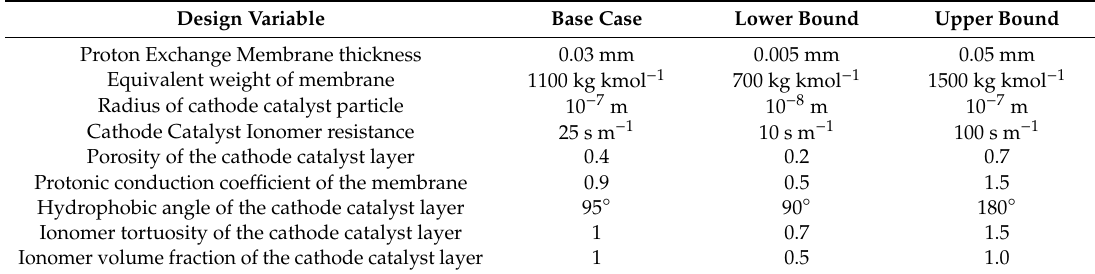
Table 4. Design variable values for the DOE method.